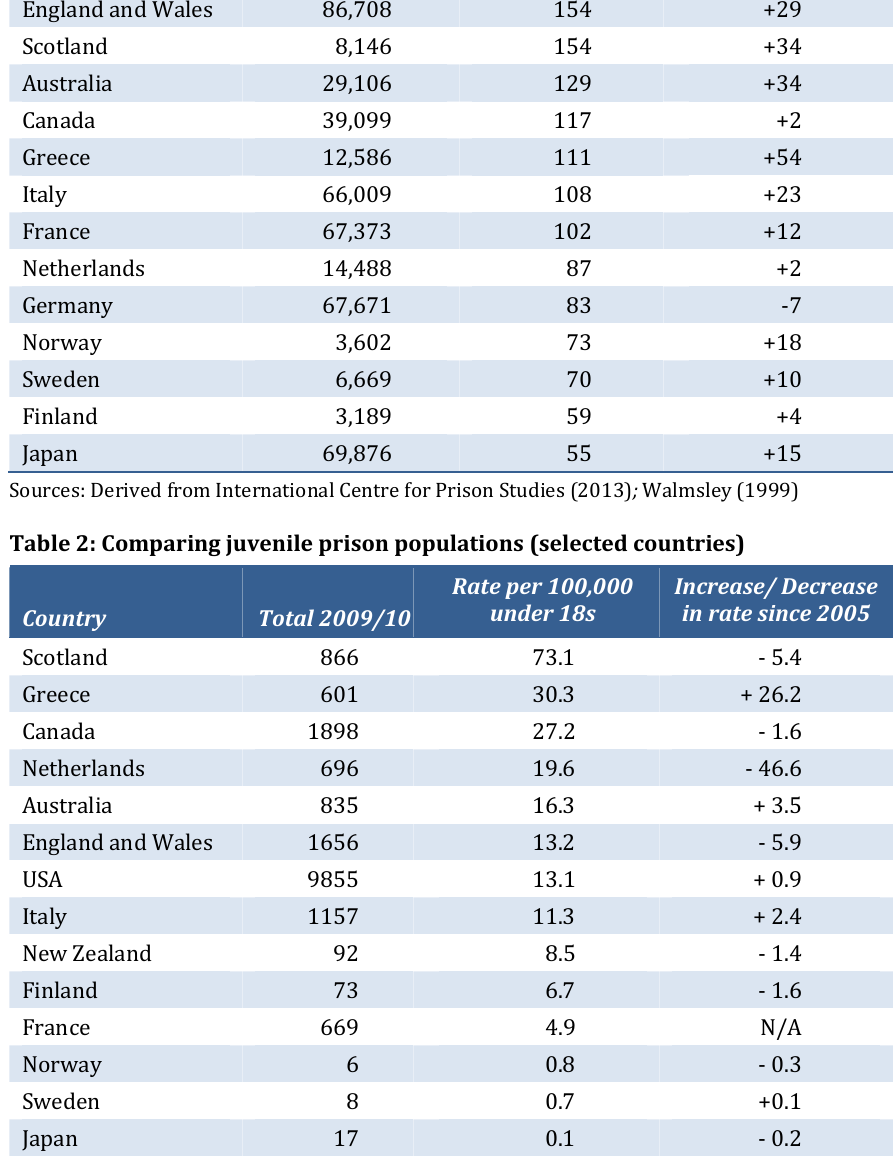
Rate per 100,000 Increase/ Decrease population in rate since 1999 2,266,832